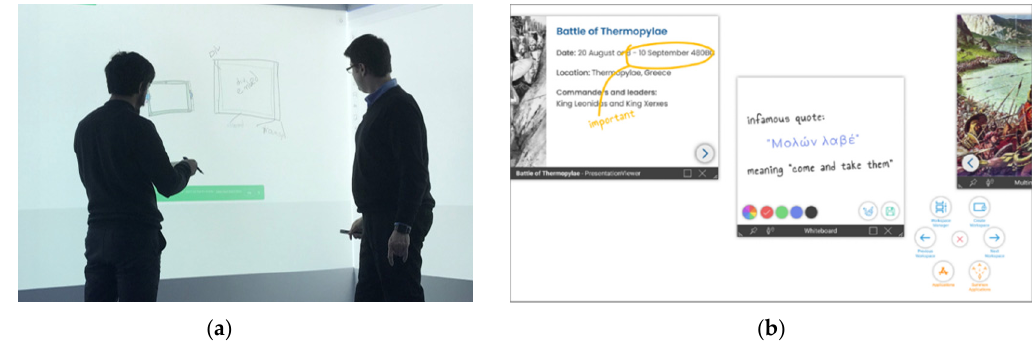
Figure 2. ( a ) Design process—low-fidelity prototypes and ( b ) high-fidelity prototypes of the CognitOS Board.